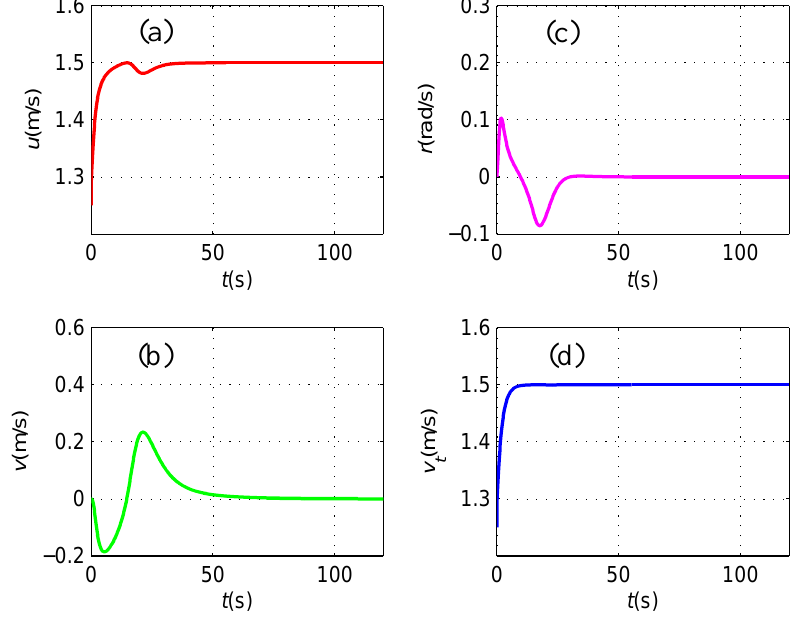
Figure 11. ( a ) Surge linear velocity u ; ( b ) Sway linear velocity v ; ( c ) Yaw angular velocity r ; and ( d ) Resultant velocity v t